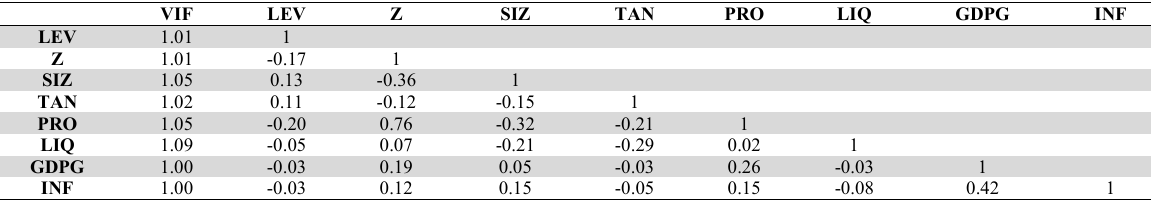
Correlation Matrix